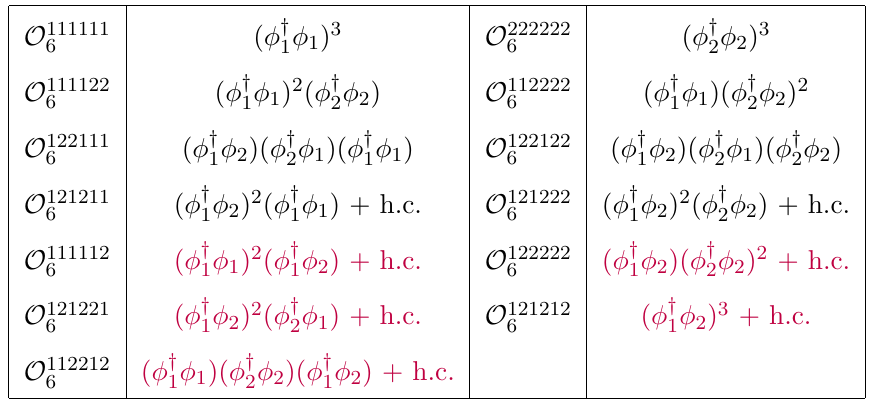
Table 4. 2HDM: (cid:30) 6 [6 + 7